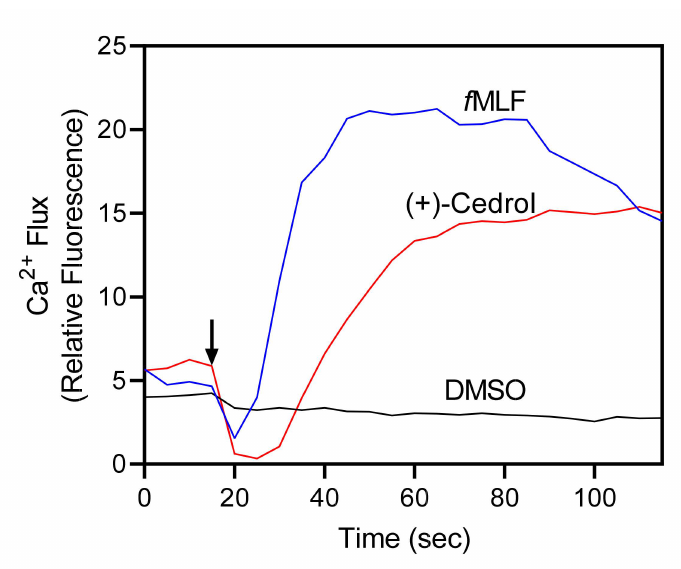
Figure 1. (+)-Cedrol induces neutrophil Ca 2+ mobilization. Human neutrophils were treated with 25 µ M (+)-cedrol, 5 nM f MLF (positive control), or 1% DMSO (negative control), and [Ca 2+ ] i was monitored for the indicated times (arrow indicates when treatments were added). The data are from one experiment that is representative of three independent experiments. Table 4. Biological activity of essential oils isolated from leaves and cones of different Juniperus species, as well as pure cedrol. Source of Juniperus Essential